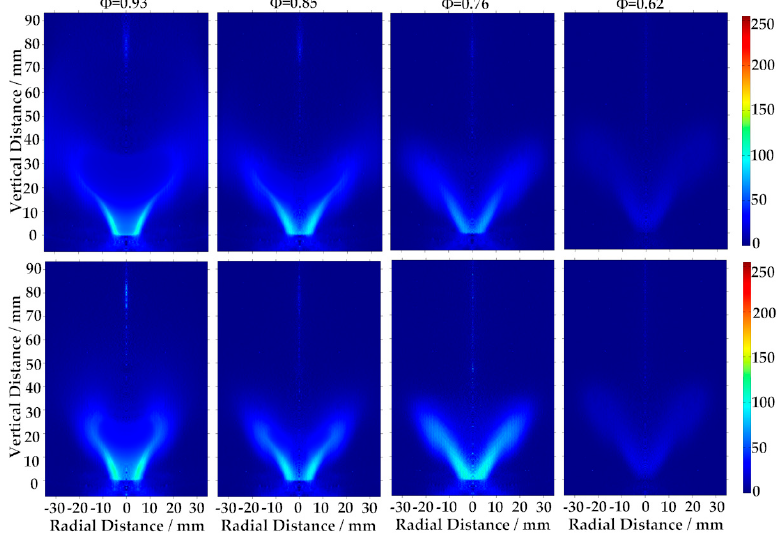
Figure 15. Evolution process of the OF30-1 (upper row) and CH4/air (lower row) flames with different equivalence ratios for a preheating temperature of 466.15 K.